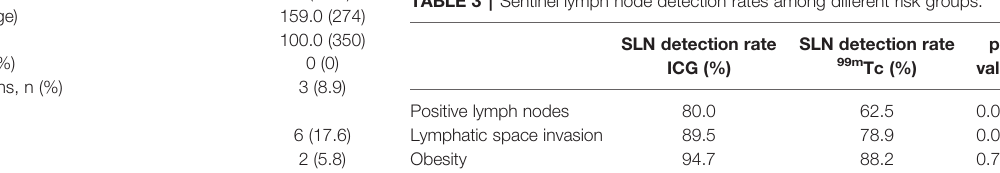
TABLE 3 | Sentinel lymph node detection rates among different risk